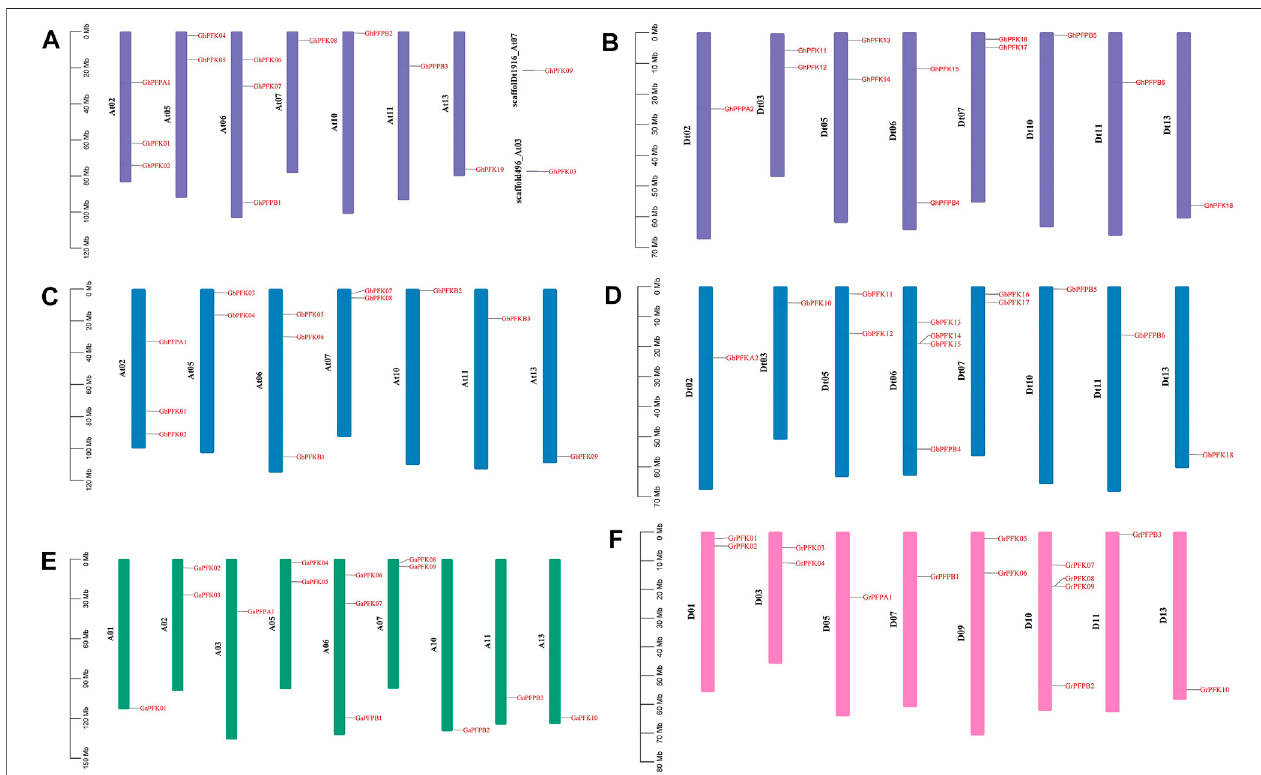
FIGURE 3 | Chromosomal location of the PFK genes. (A) G. hirsutum At subgenome; (B) G. hirsutum Dt subgenome; (C) G. barbadense At subgenome; (D) G. barbadense Dt subgenome; (E) G. arboreum; (F) G. raimondii .